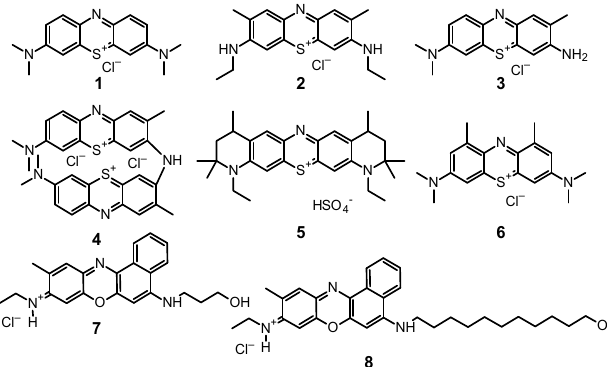
Figure 3. Chemical structures of ( 1 – 8 ) .